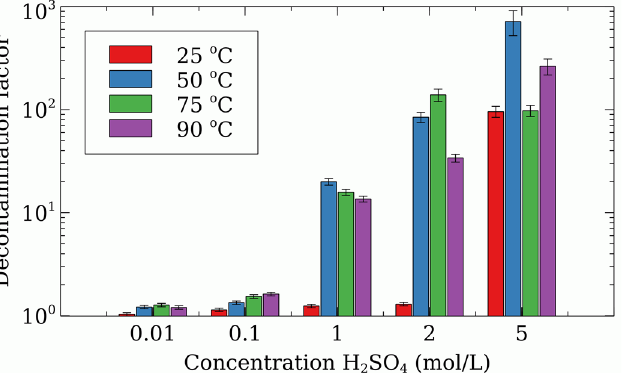
Figure 3. The dependence of DF on the concentration of H 2 SO 4 and solution temperature. Contact time—48 h.